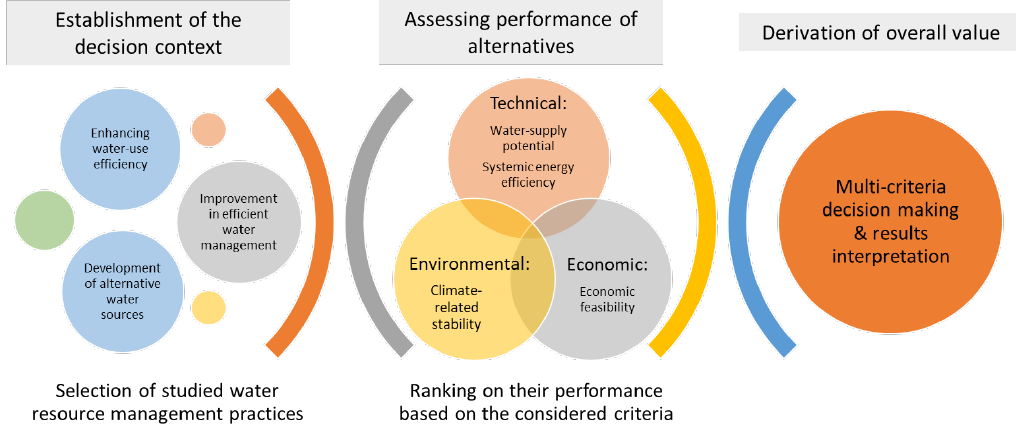
Figure 2. Overview of the design of the MCDA processes in this study.